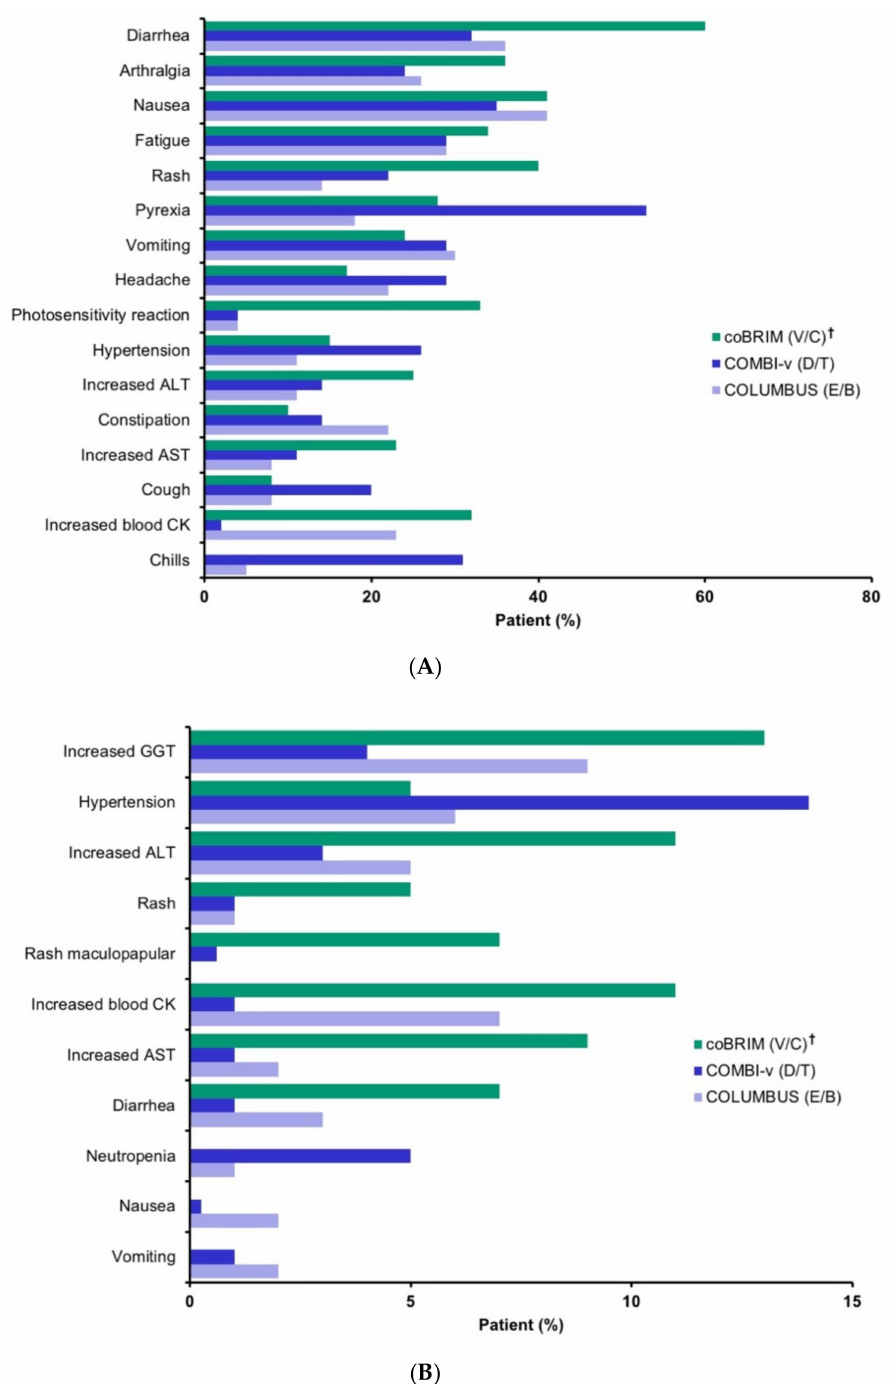
Figure 2. Adverse events (AEs) in ( A ) ≥ 20% of patients and in any combination treatment arm, and ( B ) grade 3 / 4 adverse events in ≥ 5% of patients in any combination treatment arm [23,31,33]. AE indicates adverse event; ALT, alanine transaminase; AST, aspartate transaminase; CK, creatinine phosphokinase; D / T, dabrafenib plus trametinib; E / B, encorafenib plus binimetinib; GGT, gamma-glutamyl transferase; NR, not reported; V, vemurafenib, V / C, vemurafenib plus cobimetinib. † The coBRIM data are from the safety update. Data for neutropenia, nausea, vomiting were not available. Events are presented in descending order of overall incidence in the combination